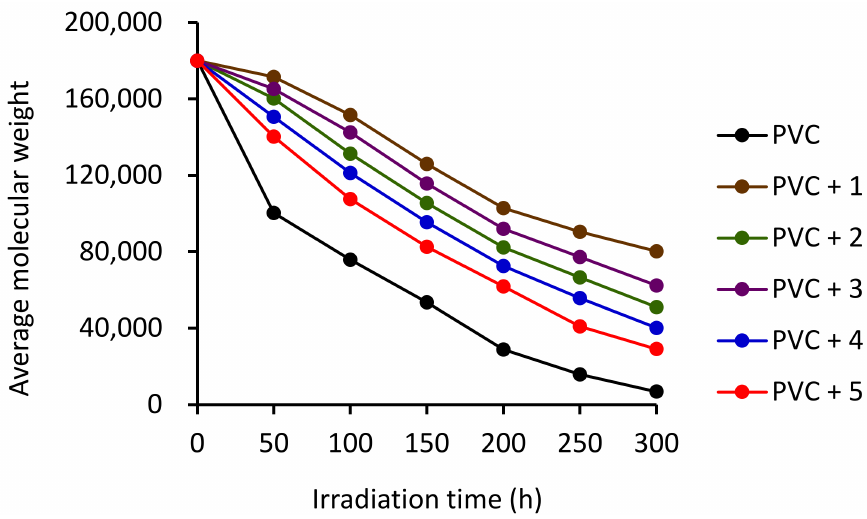
Figure 3. A plot of average molecular weight against irradiation time for PVC films.